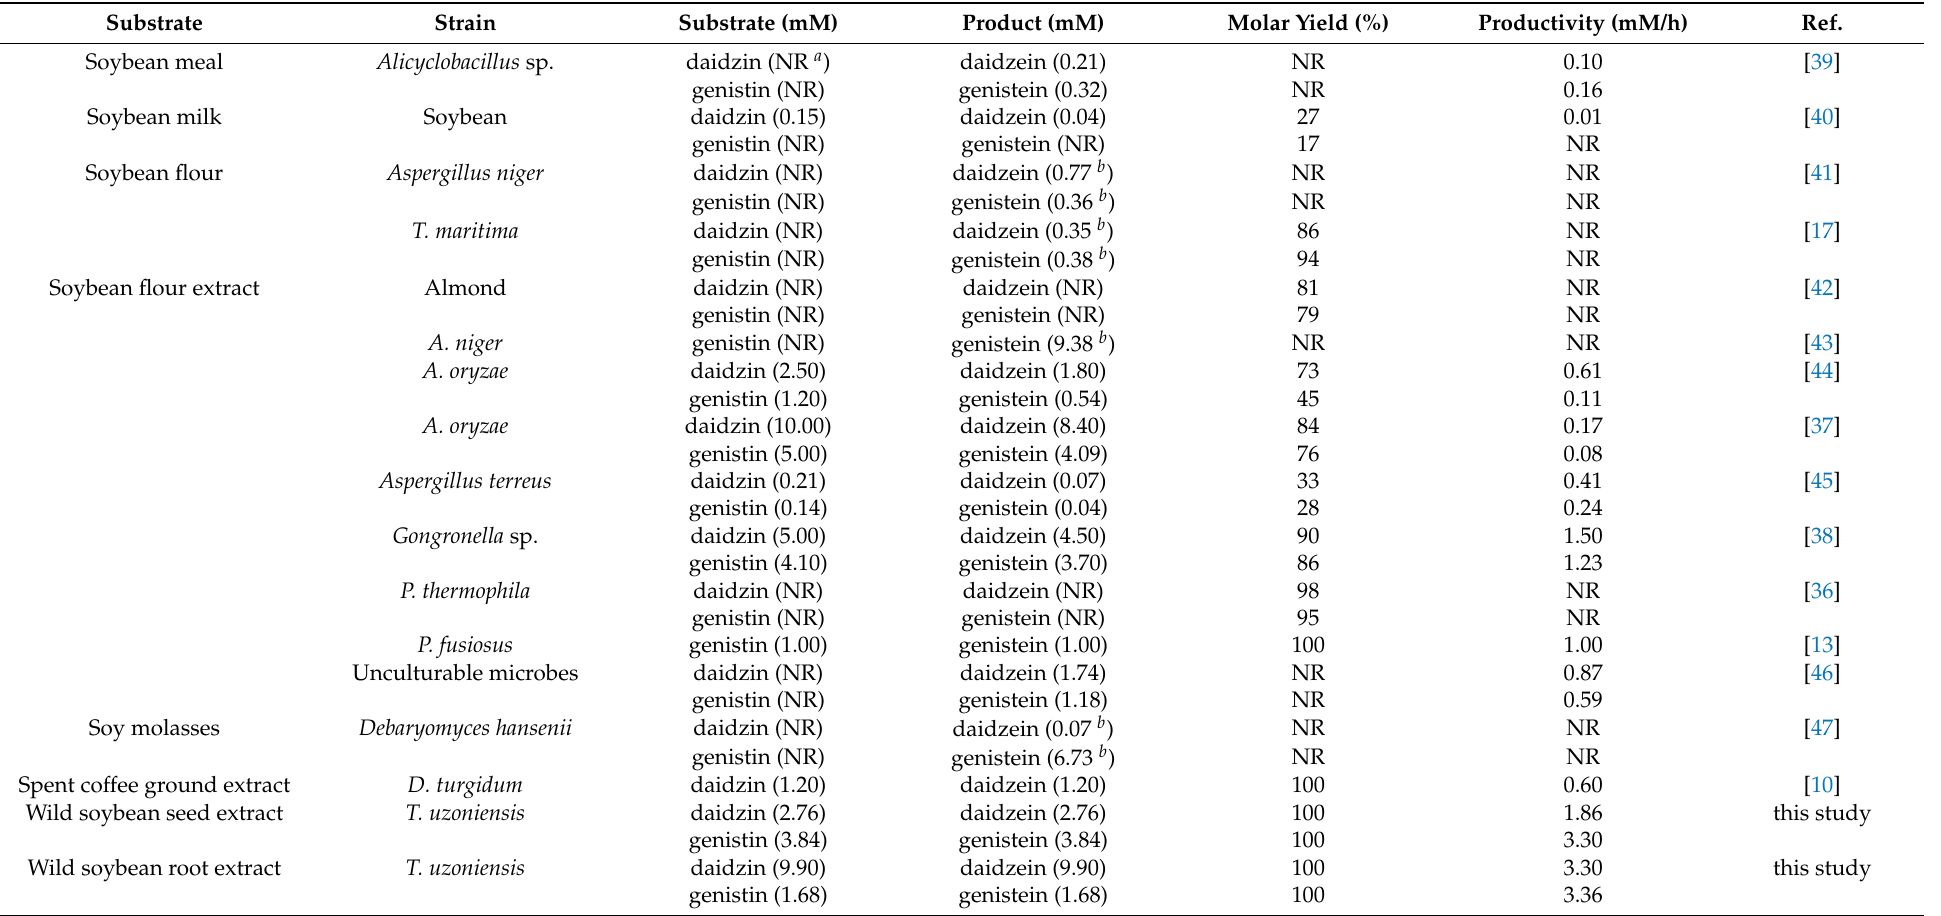
Table 3. Production of daidzein and genistein from complex substrates by